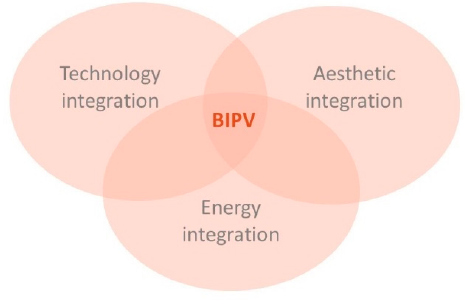
Figure 1. Multilevel BIPV integration aspects.